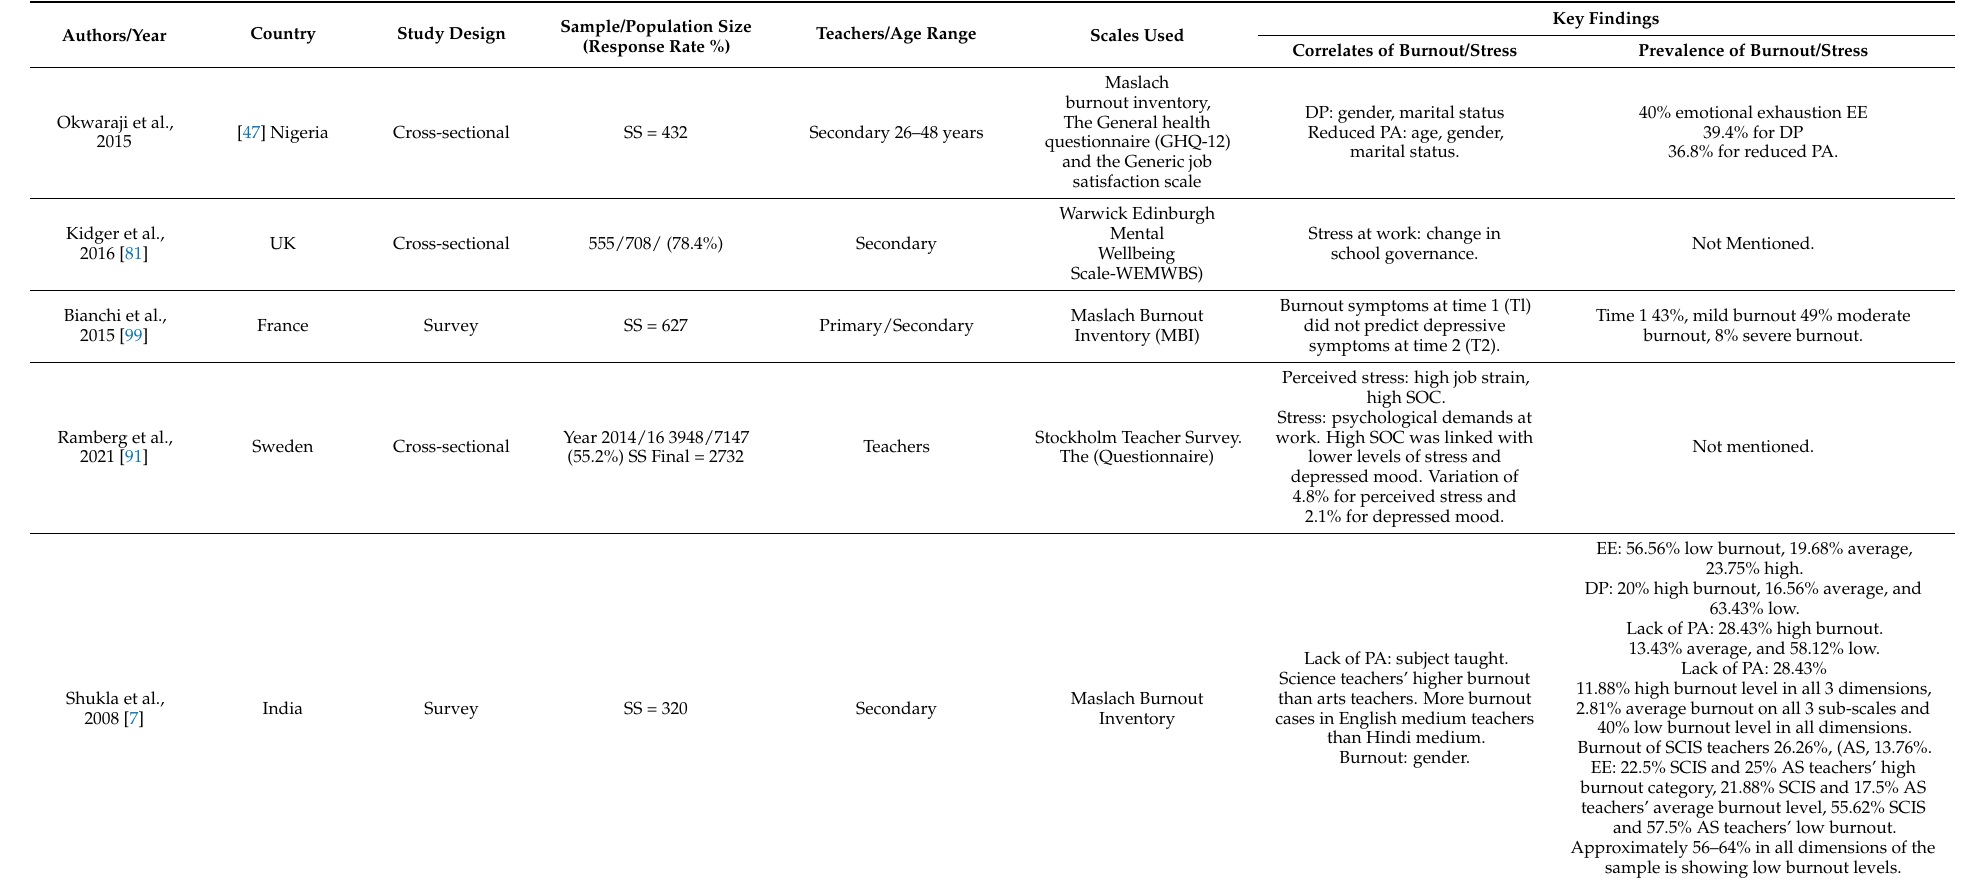
Table A1. Summary of studies with prevalence and correlates of